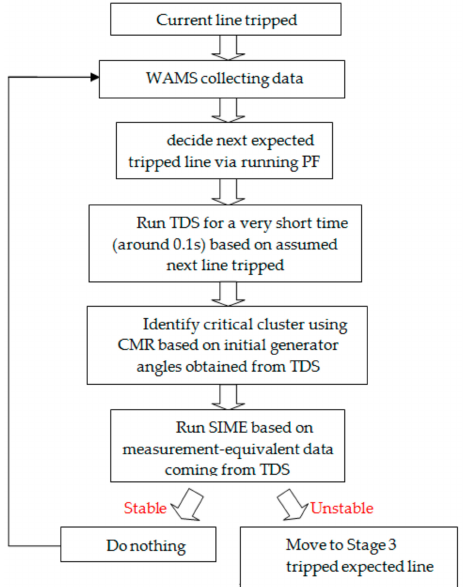
Figure 3. Flowchart of applying single machine equivalent (SIME) online to determine when to